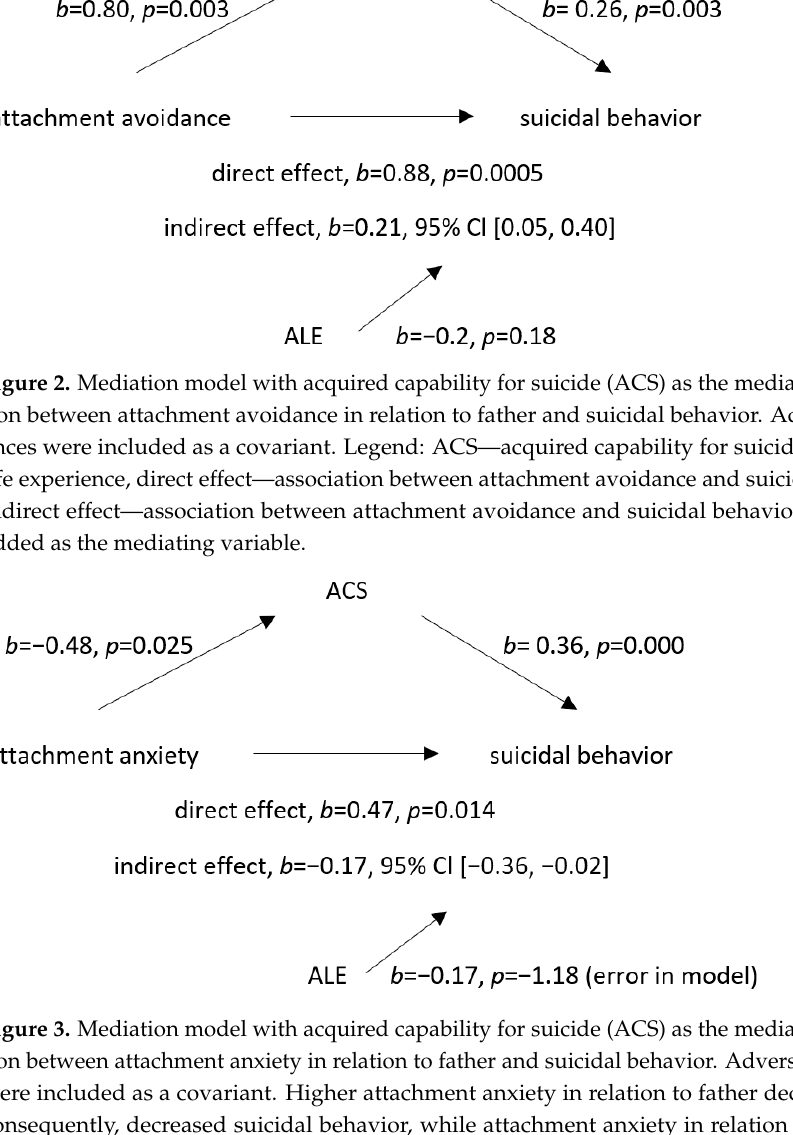
Figure 2. Mediation model with acquired capability for suicide (ACS) as the mediator of the association between attachment avoidance in relation to father and suicidal behavior. Adverse life experiences were included as a covariant. Legend : ACS—acquired capability for suicide, ALE— adverse life experience, direct effect—association between attachment avoidance and suicidal behavior, and indirect effect—association between attachment avoidance and suicidal behavior when ACS was added as the mediating variable.